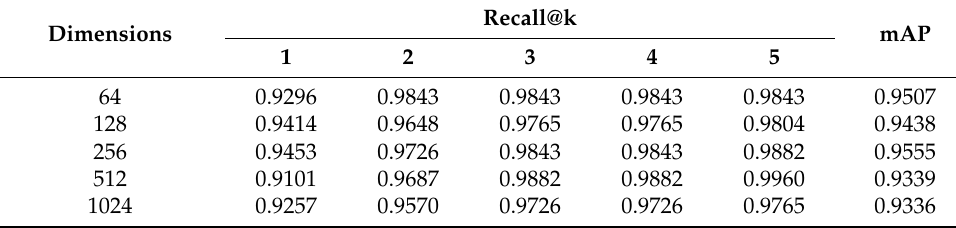
Table 4. Recall@k and mAP comparison using different numbers of embedding dimensions.